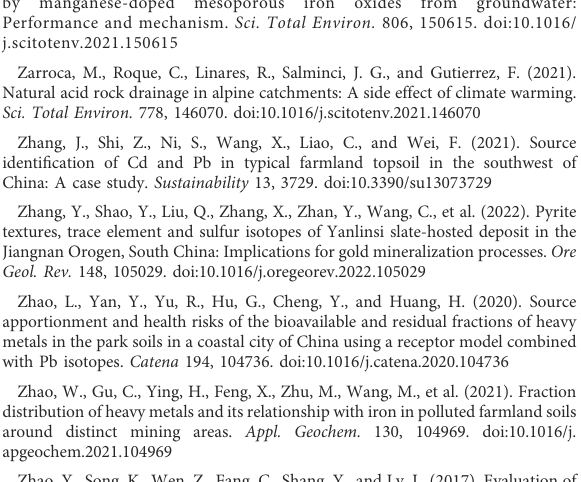
Tabelin, C. B., Sasaki, R., Igarashi, T., Park, I., Tamoto, S., Arima, T., et al. (2017). Simultaneous leaching of arsenite, arsenate, selenite and selenate, and their